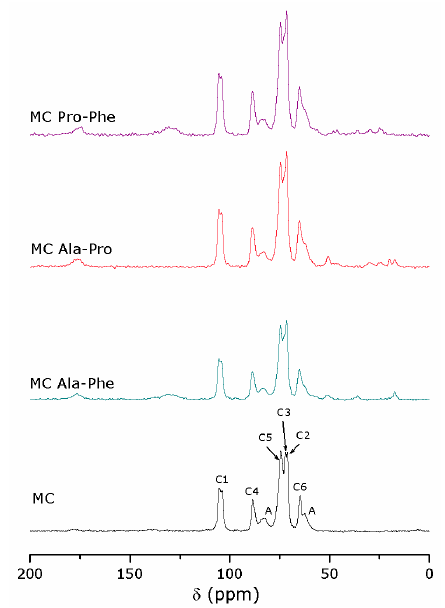
Figure 3. 13 C CP MAS NMR spectra of microcrystalline cellulose and microcrystalline cellulose loaded with amino acids.